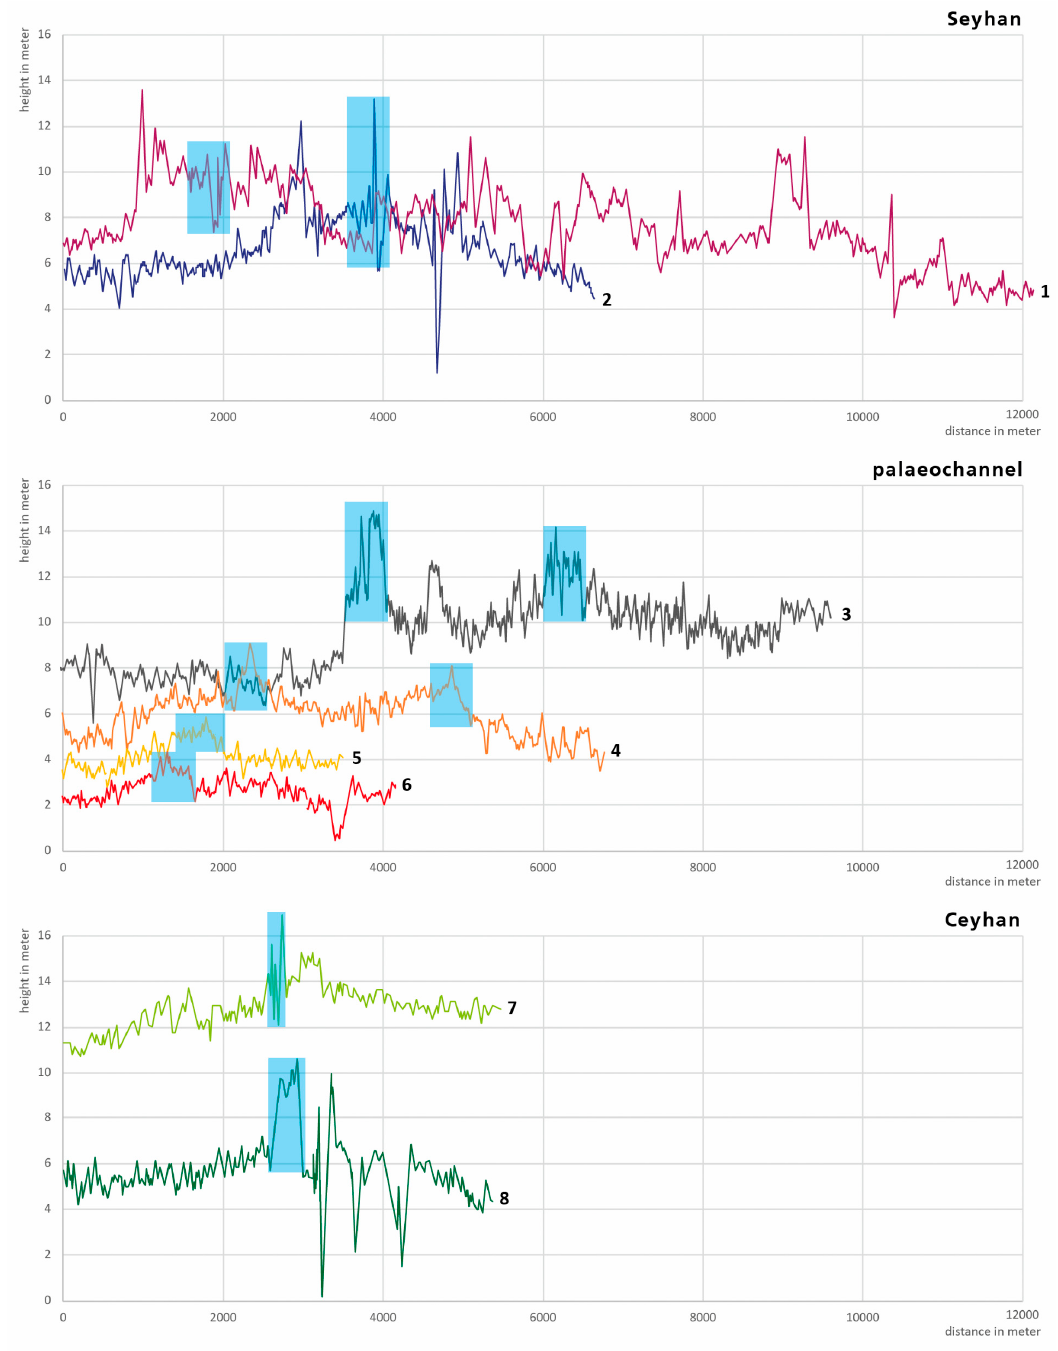
Figure 10. Cross sections of height values from the TanDEM-X DEM for the rivers Seyhan and Ceyhan and the large palaeochannel. For the location, see Figure 9. The blue rectangles mark the location of the riverbed resp. palaeochannel © Susanne Rutishauser.